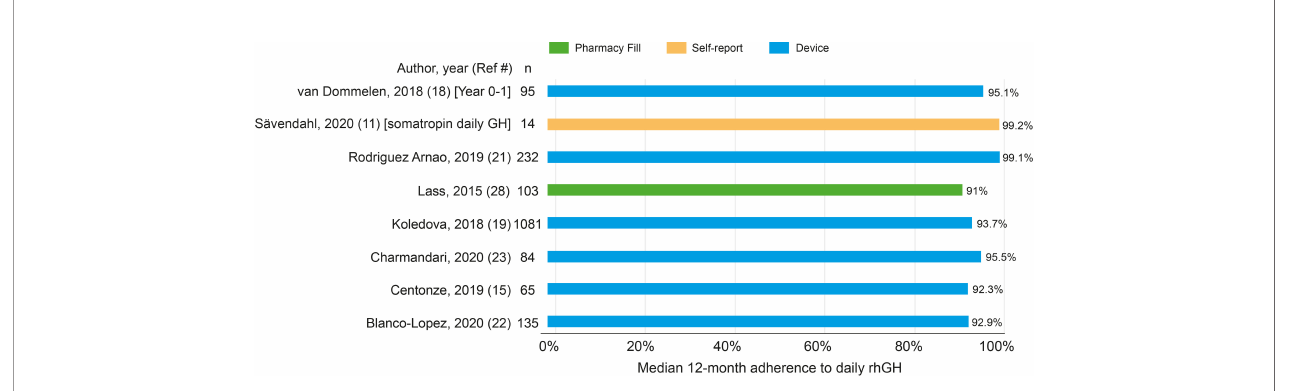
FIGURE 3 | Median 12-month adherence among eight rhGH studies. rhGH, recombinant human growth